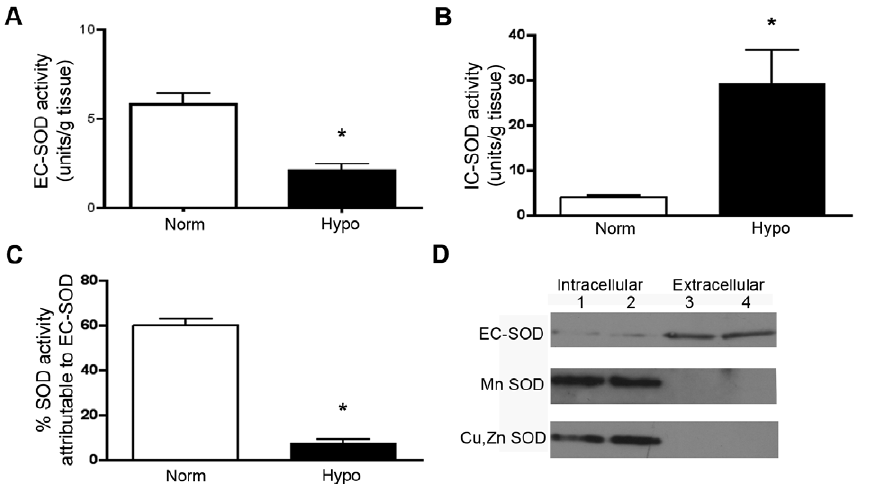
Figure 1. EC-SOD is decreased in the pulmonary artery in response to chronic hypoxia. In pulmonary artery tissue homogenates from two-week old chronically hypoxic (Hypo) and age-matched normoxic (Norm) control calves, extracellular SOD was separated from intracellular SODs (Cu,Zn SOD or SOD1 and Mn SOD or SOD2) using a concavalin A sepharose column, based on EC-SOD’s predominantly glycosylated state that enables it to bind to the column and thus separate intracellular SODs (nonbound) from extracellular SOD (bound, then eluted) fraction. SOD activity was measured in each fraction using the SOD assay kit-WST. A. EC-SOD activity. B. Intracellular SOD (IC-SOD) activity. C. The percent of total SOD activity attributable to EC-SOD. Data expressed as mean 6 SEM. *p , 0.05 vs. Norm; n=5. D. Western blot analysis of Cu,Zn SOD, Mn SOD and EC-SOD in the intracellular and extracellular fractions to confirm adequate separation of IC-SOD from EC-SOD. Lane 1 and 2 are the intracellular fractions from the two normoxic calves and the corresponding extracellular fraction is shown in Lanes 3 and 4.